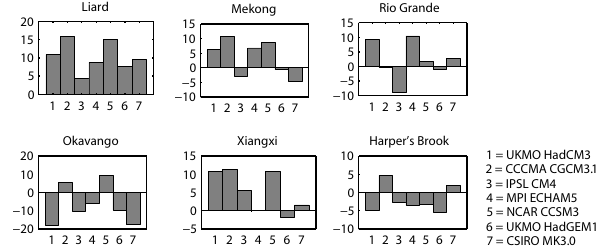
Fig. 4. Change in total-annual precipitation relative to baseline (ver- tical axis; %) for for the 7 GCMs under 2 ◦ C prescribed warming (horizontal axis), for each catchment.